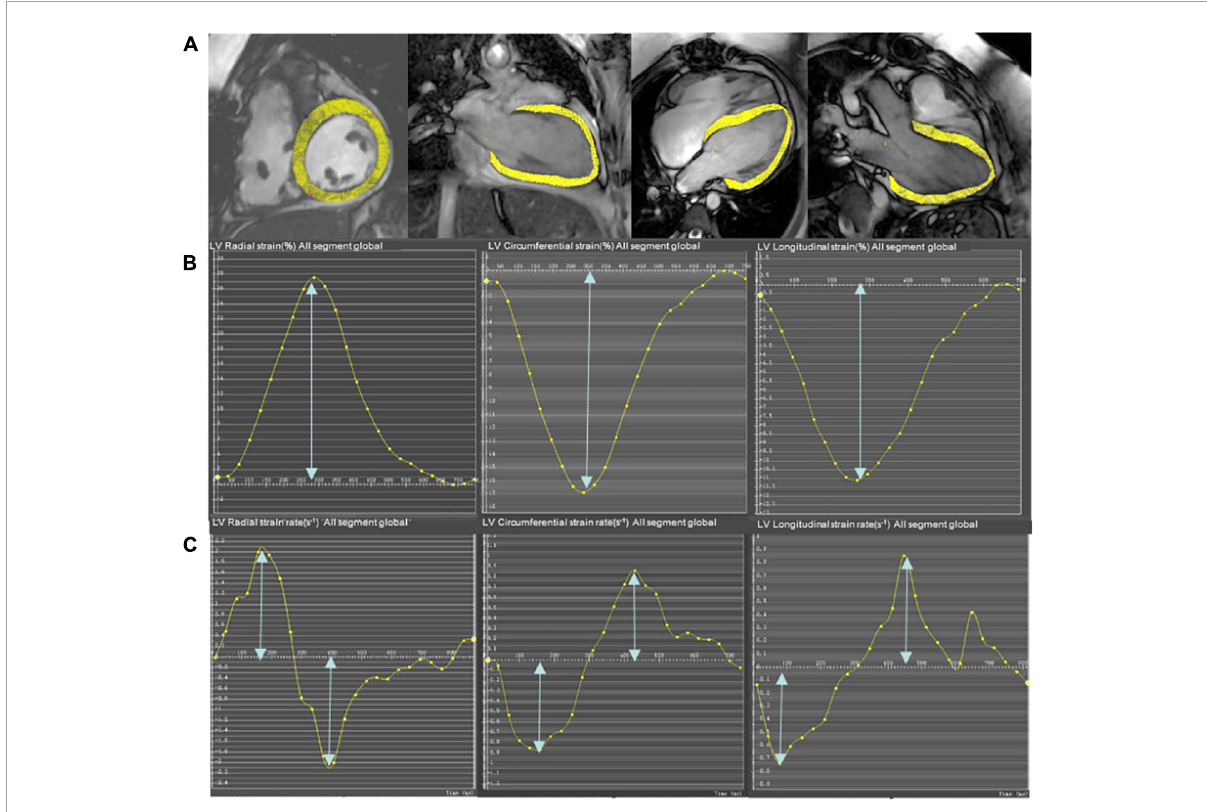
FIGURE1 Representative short-axis and long-axis images (A) , strain curves (B) , and strain rate curves (C) in a participant who underwent pulmonary valve replacement (PVR). The epicardial and endocardial borders (excluding papillary muscles and trabeculae) at end-diastole are semi-manually defined in the LV 4-chamber, LV 2-chamber, and LV 3-chamber to calculate longitudinal strain and strain rate. The entire LV short-axis SSFP cine images are used to calculate radial and circumferential strain and strain